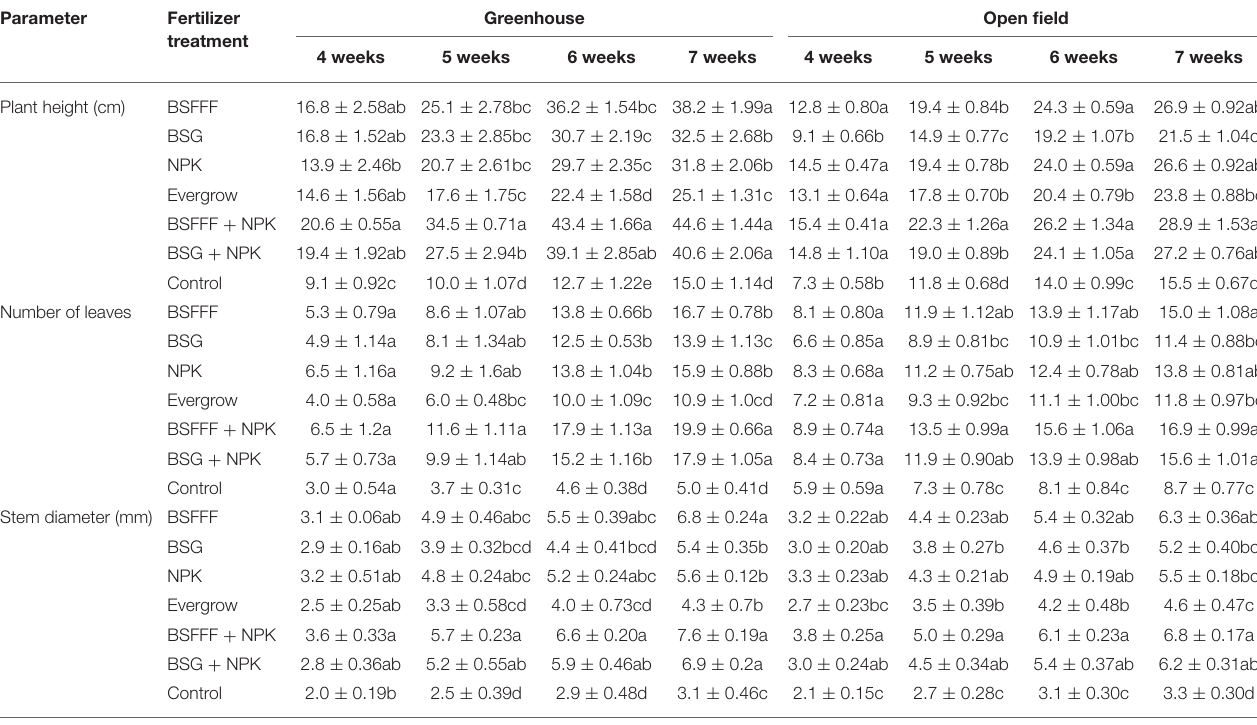
TABLE 5 | Effect of composted BSF frass, conventionally composted BSG, and commercial fertilizers on the growth of French beans.